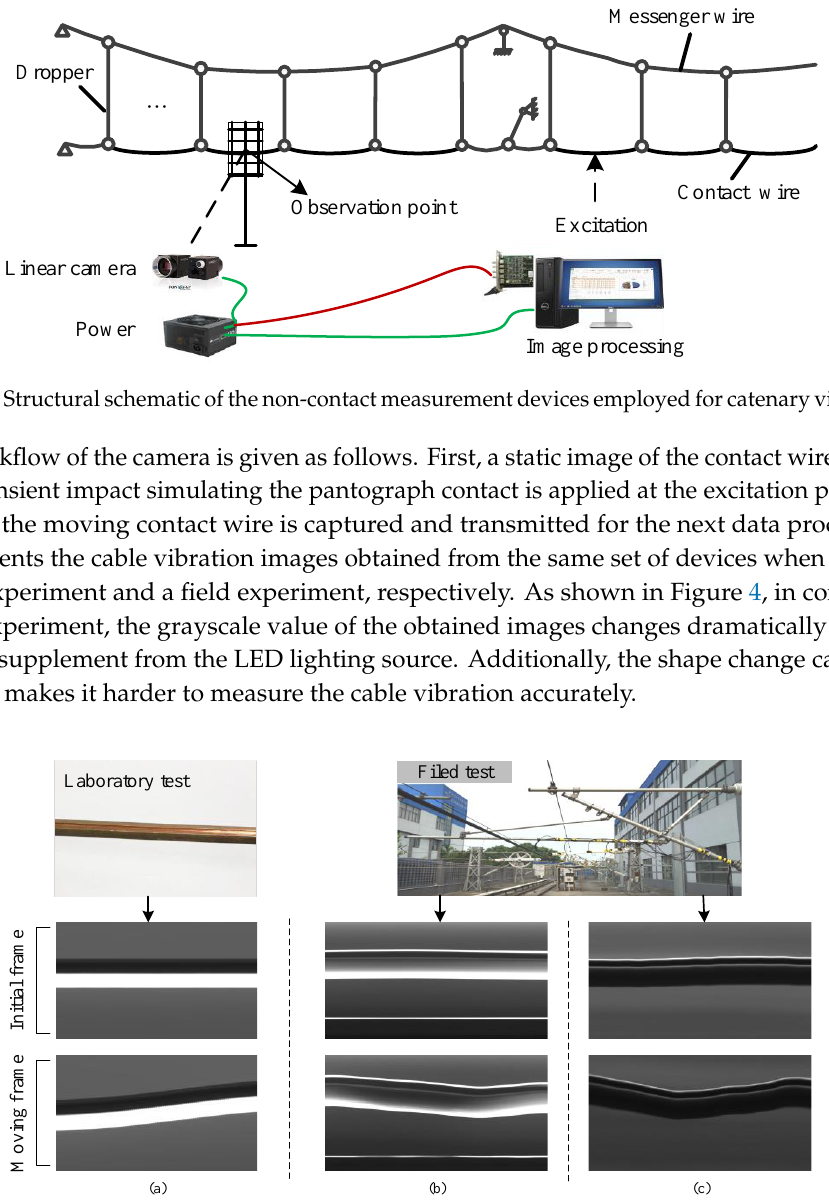
Figure 4. Contact wire vibration images obtained from the non-contact measurement system. ( a ) Contact wire images obtained from the laboratory test with an illumination supplement. ( b ) Contact wire images obtained under strong sunlight. ( c ) Contact wire images obtained under weak sunlight.